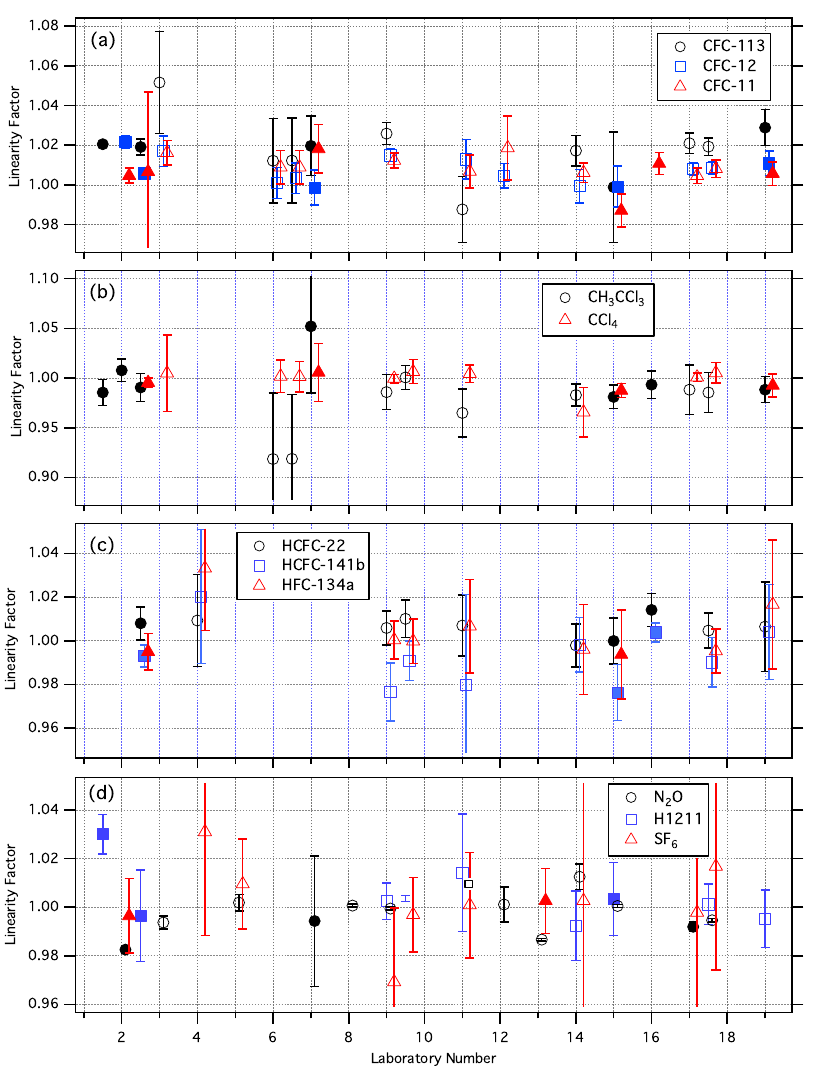
Fig. 8. Linearity factors relative to NOAA for select gases. A linearity factor of 1.0 corresponds to scale factors that are the same for both diluted and undiluted samples (NOAA results used for comparison are 1.0 by default and are not shown). Filled symbols denote laboratories that develop calibration scales, while open symbols denote those that adopt existing scales (see Table S1 for scale definitions). Note that symbol colors do not indicate common scales, as was the case in Figs. 1–6. Data have been shifted on the x axis for clarity. Error bars are 1 s.d. Linearity factors are relative to NOAA ECD results in panels (a) , (b) , and (d) , and to NOAA MS results in panel (c) .